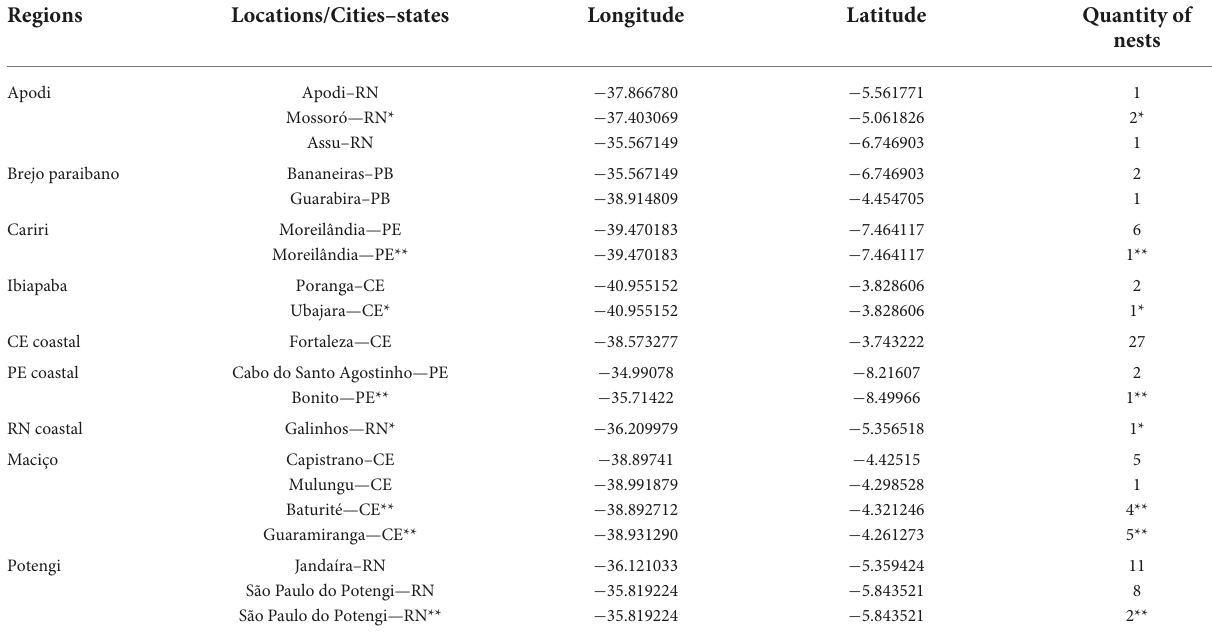
TABLE 1 Quantity of studied nests of Plebeia flavocincta (Apidae: Meliponini) at 18 locations (15 nests wing geometric morphometry analysis and 16 nests for mitochondrial DNA analysis). Regions Locations/Cities–states Longitude